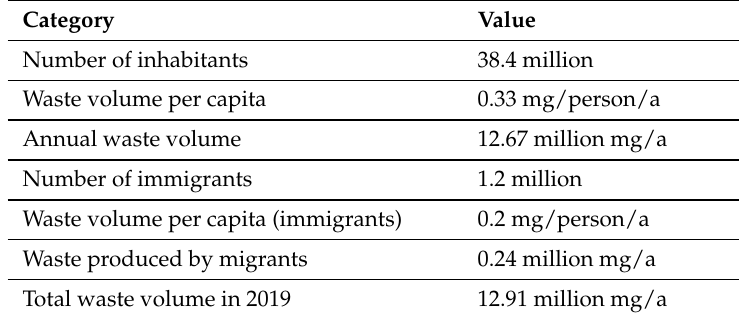
Table 4. Volume of mixed municipal waste in Poland per annum. (Data source: Statistics Poland).